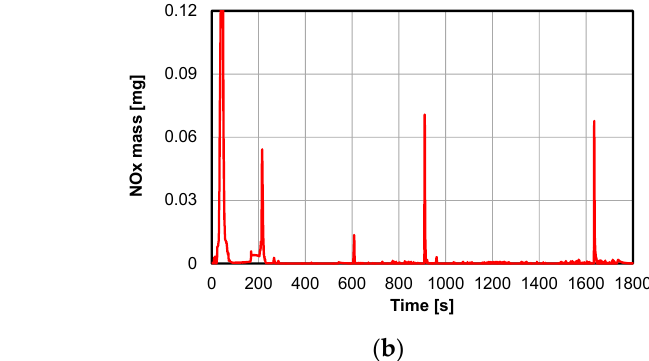
Figure 19. The NO x mass versus time for: ( a ) plug-in; ( b ) HEV.